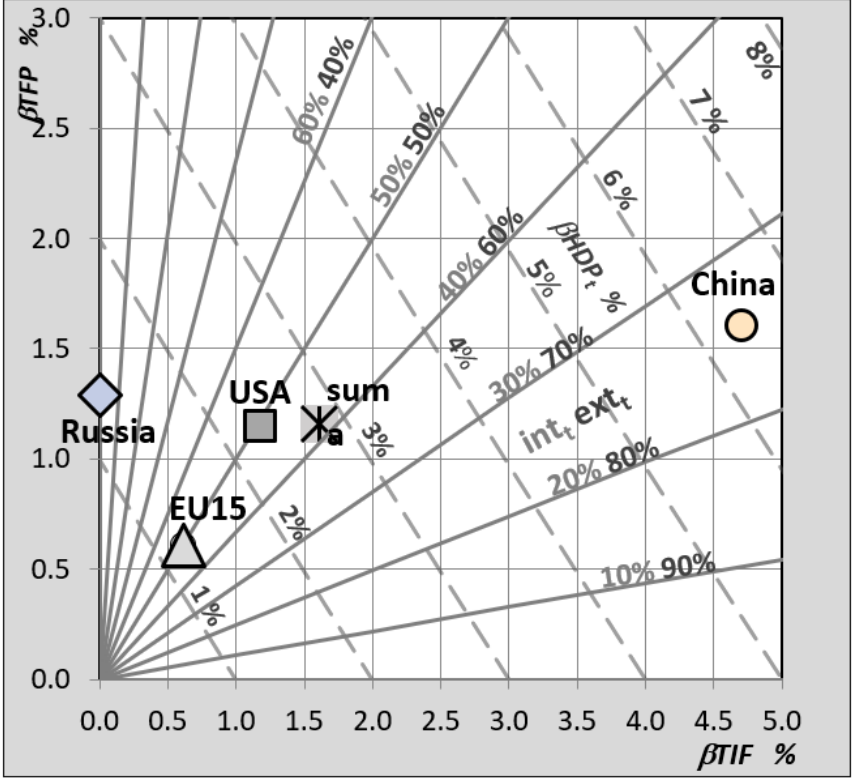
Figure 9. Quality of the development of important economic entities for the period of 1960 – 2021.